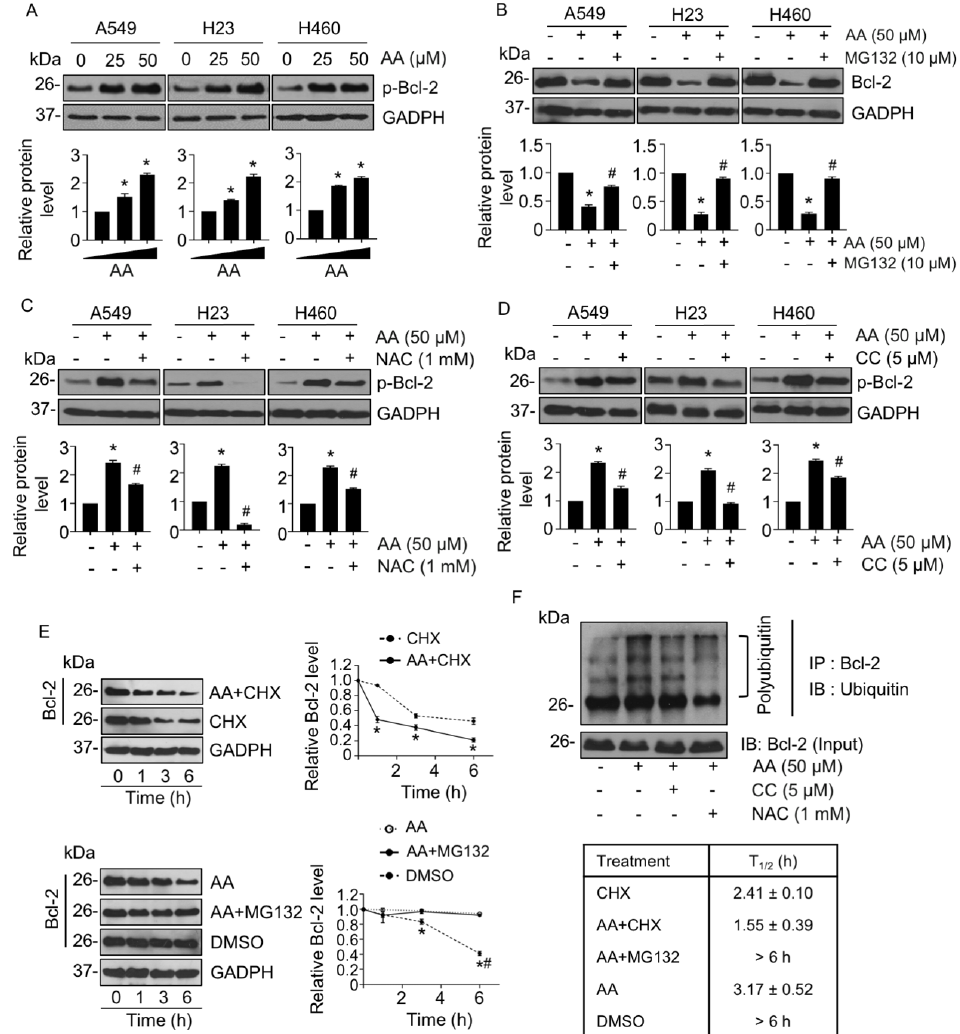
Figure 6. Aspiletrein A (AA) mediated Bcl-2 degradation via a ubiquitin-proteasomal mechanism. ( A ) Lung cancer cells were treated with AA (0–50 μM) for 24 h. The level of p-Bcl-2 was analyzed via Western blotting ( B ) Lung cancer cells were pretreated with MG132 (10 μM) for 1 h in the pres- ence or absence of AA (50 μM) for 24 h. The level of Bcl-2 was analyzed via Western blotting analy- sis. Lung cancer cells were pretreated with ( C ) N-acetylcysteine (NAC, 1 mM) or ( D ) compound C (CC, 5 μM) in the presence or absence of AA (50 μM) for 24 h. The level of p-Bcl-2 was analyzed via Western blotting. Blots were re-probed with anti-GAPDH to confirm equal loading. Protein level was quantified and presented as relative value to the control. Data are mean ± SEM ( n = 4). * p < 0.05 vs. control cells, # p < 0.05 vs. AA-treated cells. ( E ) Lung cancer A549 cells were pretreated with either cycloheximide (CHX, 10 μg/mL) or MG132 (10 μM) for 1 h prior to incubation with AA (50 μM) or AA alone for 0–6 h. The level of Bcl-2 was analyzed via Western blotting. Protein half-life (T 1/2 ) was analyzed and presented on the right. Blots were re-probed with anti-GAPDH to confirm equal load- ing. Protein level was quantified and presented a relative value to that of the control. Data are mean ± SEM ( n = 4). * p < 0.05 vs. CHX or DMSO treated cells, # p < 0.05 vs. combination of MG132- and AA-treated cells. ( F ) Lung cancer A549 cells were pretreated with or without CC (5 μM) or NAC (1 mM), prior to AA (50 μM) for 3 h. Polyubiquitination of Bcl-2 was analyzed using immunoprecipi- tation with an antibody to Bcl-2 and immunoblotting with an antibody to ubiquitin. Represented blots from three independent experiments are shown.